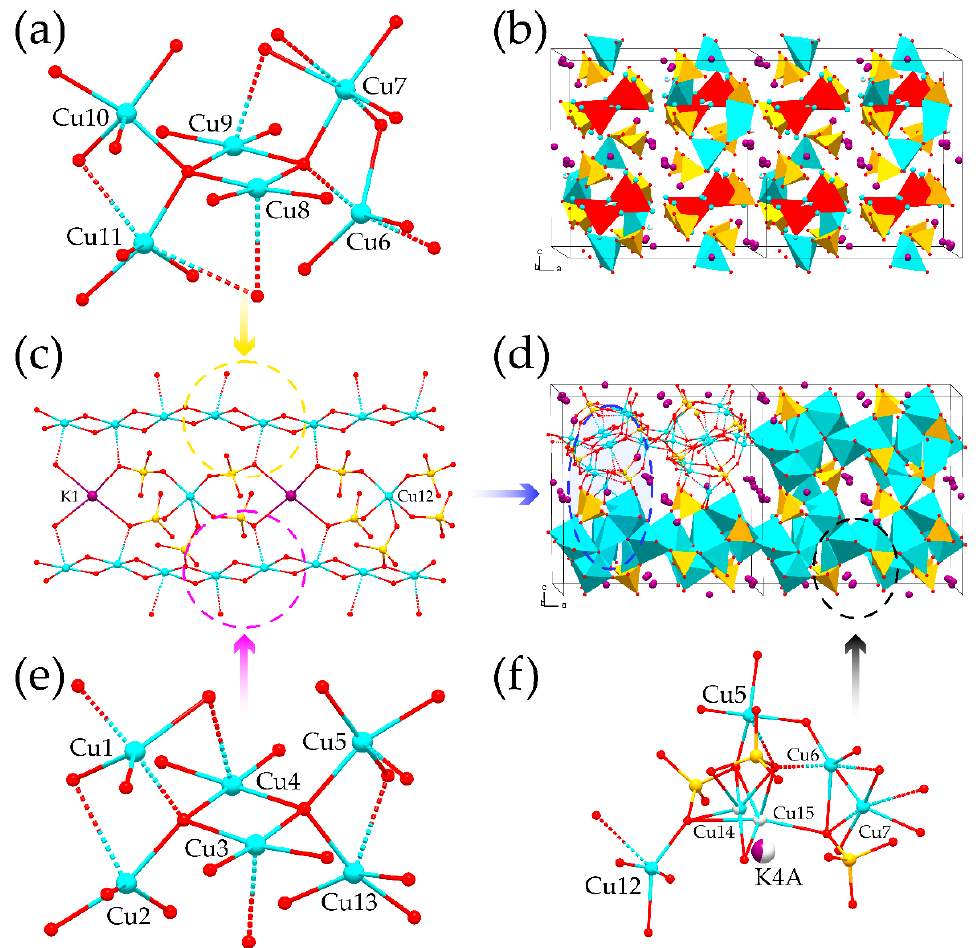
Figure 2. The key features of the crystal structure of 2 : ( a ) the fragment of the Cu9 ··· Cu8 rod; ( b ) the arrangement of anion-centered tetrahedra (shown in red); ( c ) two symmetrically distinct rods linked via the Cu12O 6 octahedra; ( d ) lateral view of the crystal structure; ( e ) the fragment of the Cu3 ··· Cu4 rod; ( f ) the disordered arrangement of the Cu14 and Cu15 sites, and associated K4A site. Disordered oxygen atoms are shown at most probable positions. Legend: as in Figure 1.